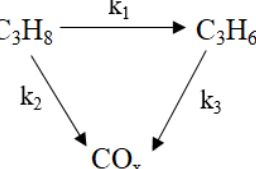
Figure 7. Reaction Network for PODH. Reprinted with permission from [60], copyright 2018, American Chemical Society.